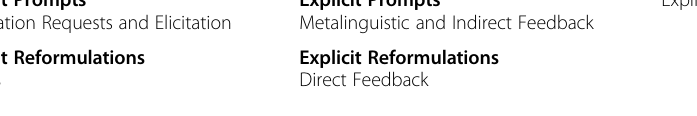
Prompts Implicit Implicit Prompts Clarification Requests and Elicitation Implicit Reformulations Recasts